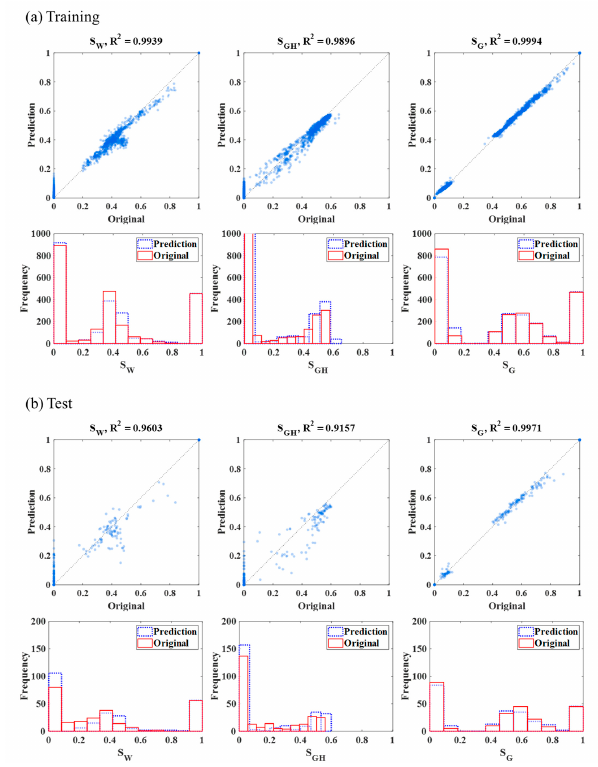
Figure 9. ( a ) Training and ( b ) test results of Case 1, each column means each saturation, water, gas hydrate, and gas with coefficient of determination. In the scatter plots, the X and Y axes indicate the given original data and the predicted value by random forest, respectively. In the histogram pictures, the X and Y axes mean each saturation and frequency, respectively.